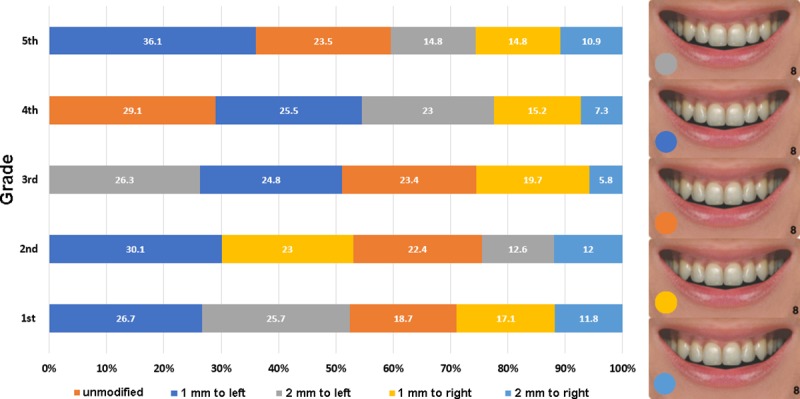
Distribution of preferences in the five grades for midline shift.The vertical line between the central incisors was shifted to the left and to the right in 1 mm steps (percentages, N = 861).